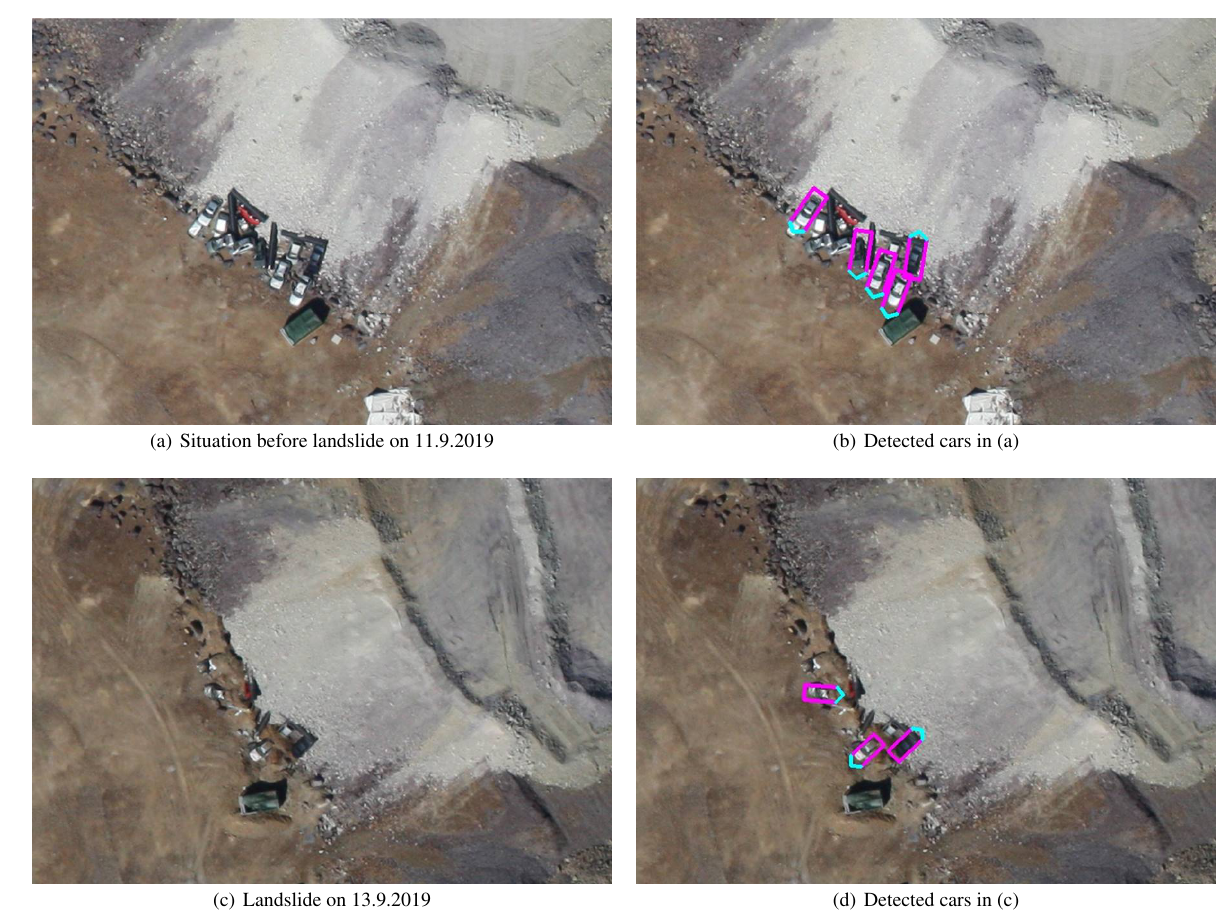
Figure 6. Detection results of partially buried cars for the landslide scenario on the 11.9.2019 and